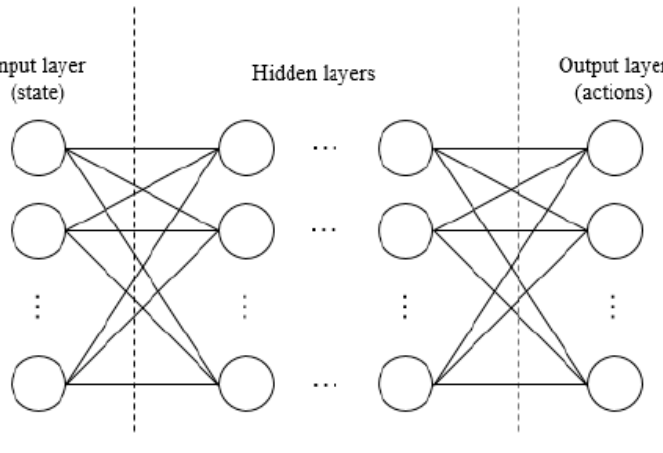
Figure 4. Deep Q-Network architecture